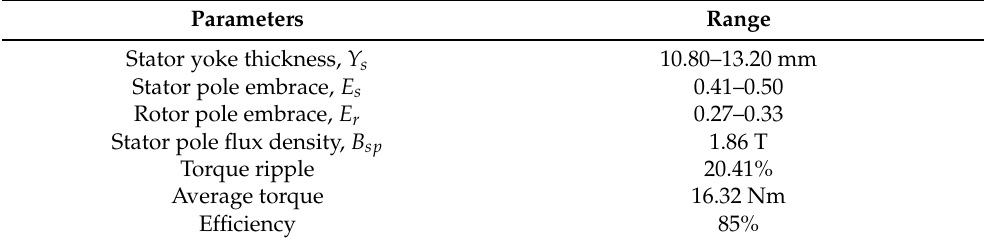
Table 2. Ranges of design